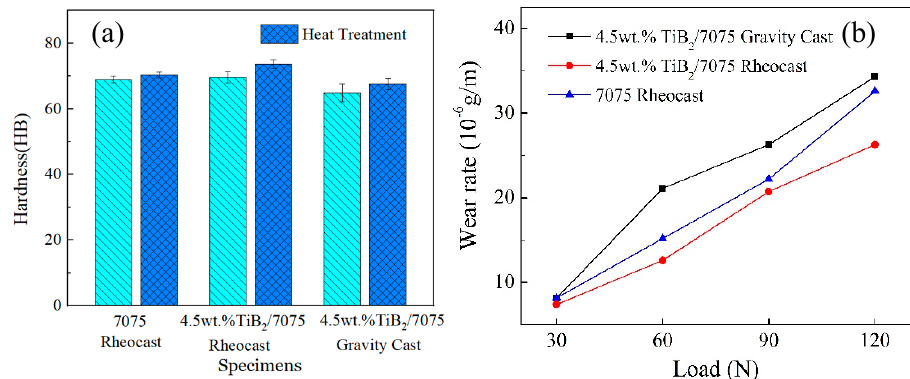
Figure 9. ( a ) Brinell hardness of specimens before and after heat treatment and ( b ) wear rate of specimens versus friction load.